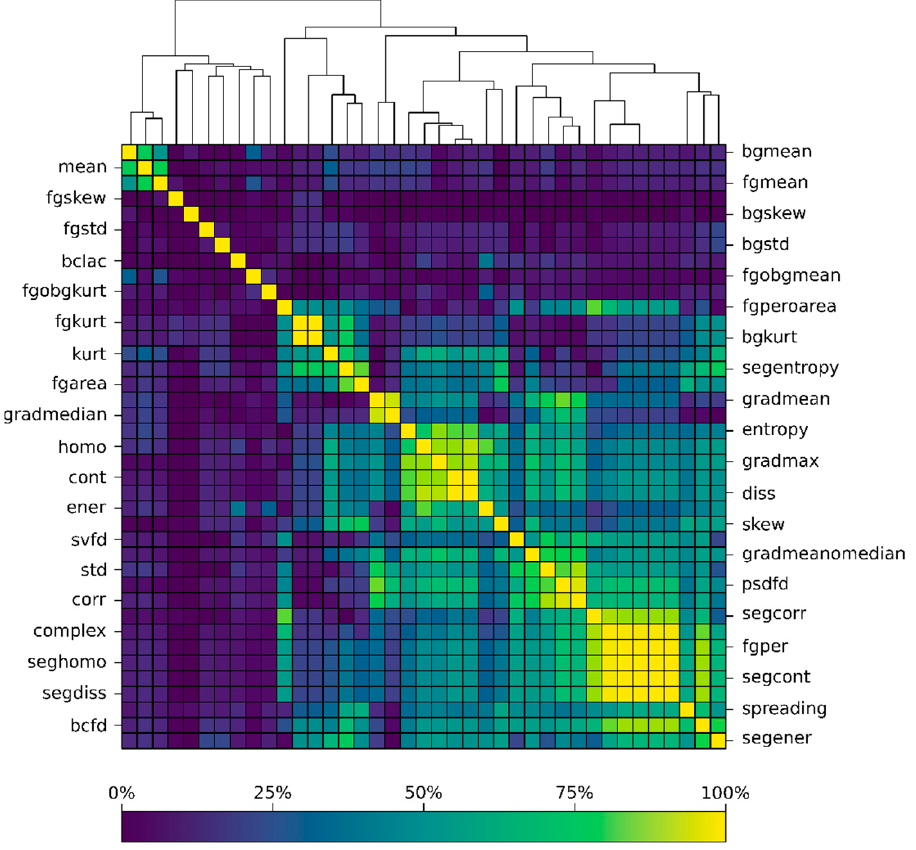
Figure 4. Dataset’s absolute correlation matrix with hierarchical clustering dendrograms.